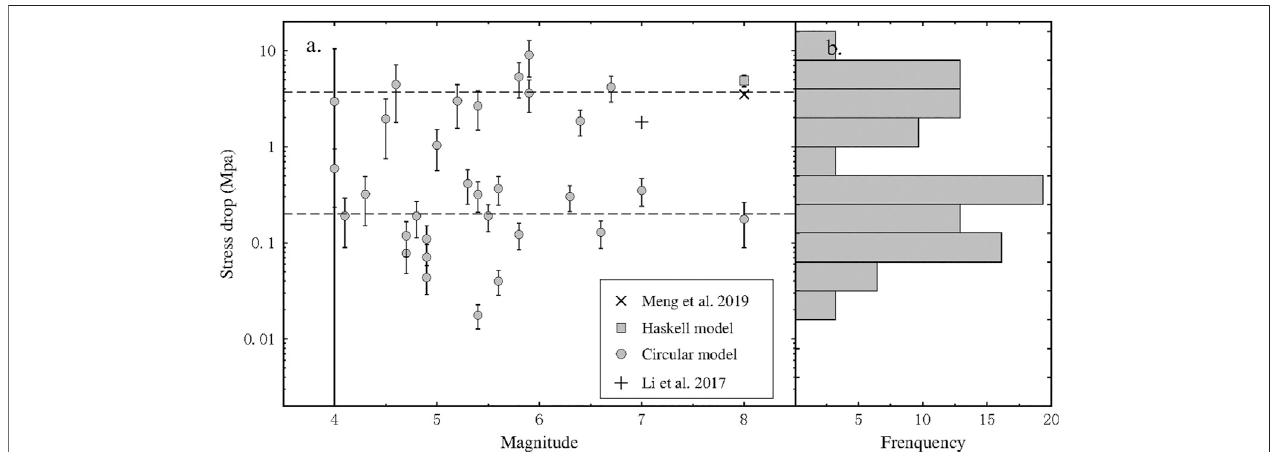
FIGURE 12 | The estimated stress drop of the analyzed earthquakes. (A) The distribution of the estimated stress drop. The circles and the squares are the predicted stress drop from circular model and Haskell model, respectively. The estimated errors computed through the error propagation theory are shown by the verticalerrorbars.Eventshavebeendividedintotwogroupsbasedon Δσ (cid:2) 0.6 MPa.Theaveragestressdropsofthesetwogroupsareshown asthedashedlines.The diagonalcrossandcrossaretheresultsofM8.0WenchuanearthquakebyMengetal.(2019)andM7.0LushanearthquakebyLietal.(2017),respectively.( B) The normalized histograms of the predicted stress